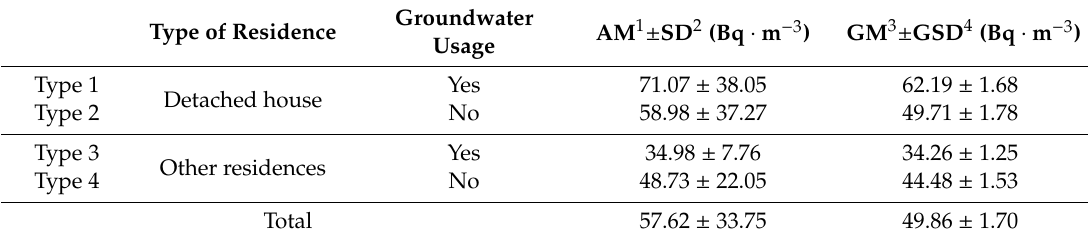
Summary of annual mean radon concentrations according to residential type and groundwater